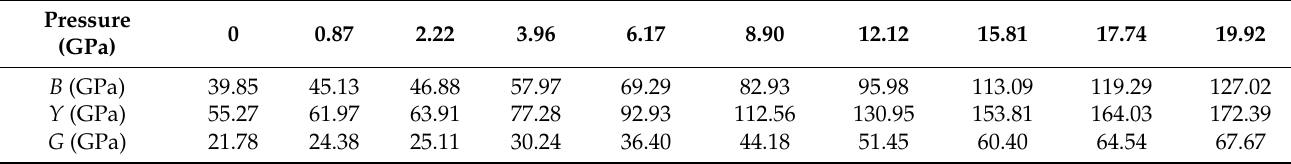
Table 13. The calculated bulk modulus ( B ), shear modulus ( G ), Young’s modulus ( Y ), Poisson’s ratio ( µ ), Pugh’s mod- ulus ( G / B ), Vicker’s hardness ( H v ), compression wave velocity ( V p ), and shear wave velocity ( V s ) of the Na-MMT at given